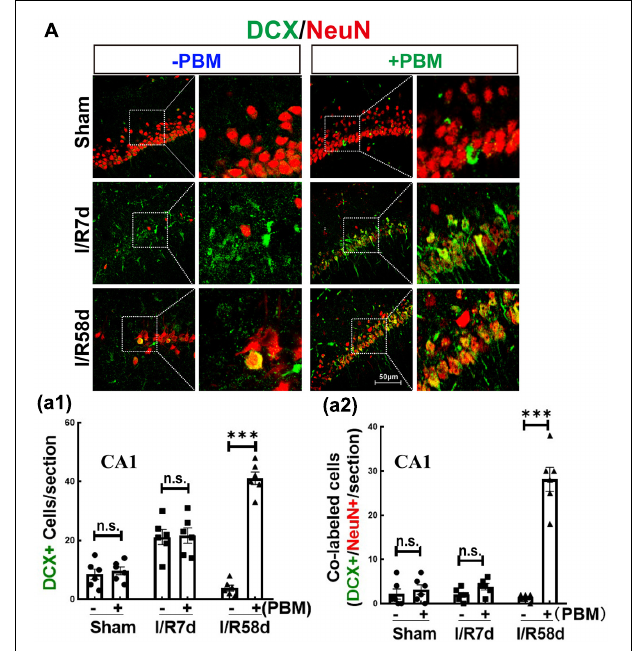
FIGURE 4 | Photobiomodulation promotes proliferating NSCs toward neurons 58 days after GCI reperfusion in the hippocampal CA1 region. Hippocampal coronal sections from sham, I/R 7 days and I/R 58 days rats treated with or without PBM were used to detect neurogenesis by IF staining. DCX is a marker of newborn immature migrating neurons, and NeuN is a marker for surviving neurons. Colabeled cells reflect proliferating neurons. (A) Representative images of double IF staining for DCX (green) and NeuN (red) in the hippocampal CA1 region. Quantification of DCX+ cells (a1) and DCX+/NeuN+ colabeled cells (yellow) (a2) in the hippocampal CA1 region ( n = 5–7 in each group). ns, no significant difference. ∗∗∗ P < 0.001 between the two groups. Scale bar: 50 µ m; magnification: 40 ×